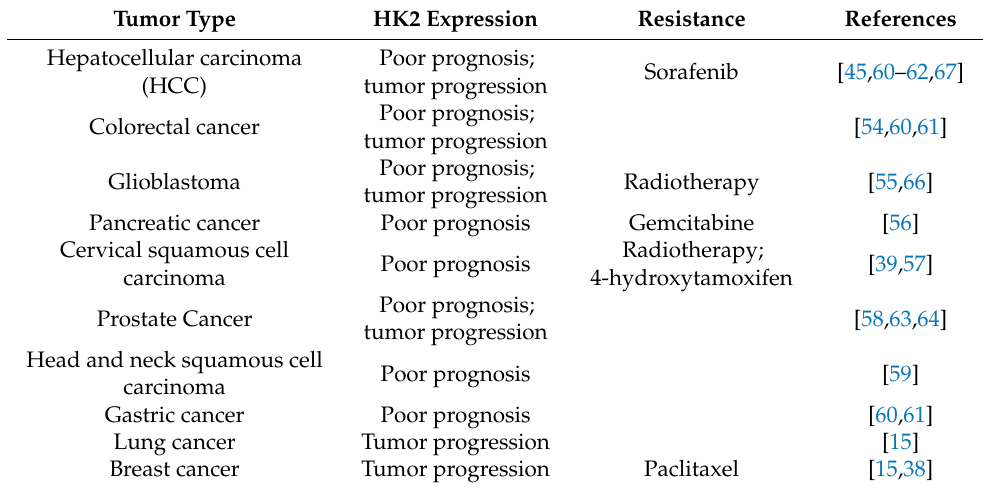
Table 1. Correlation of HK2 (over)expression with prognosis, tumor progression and treatment resistance in different type of human and murine